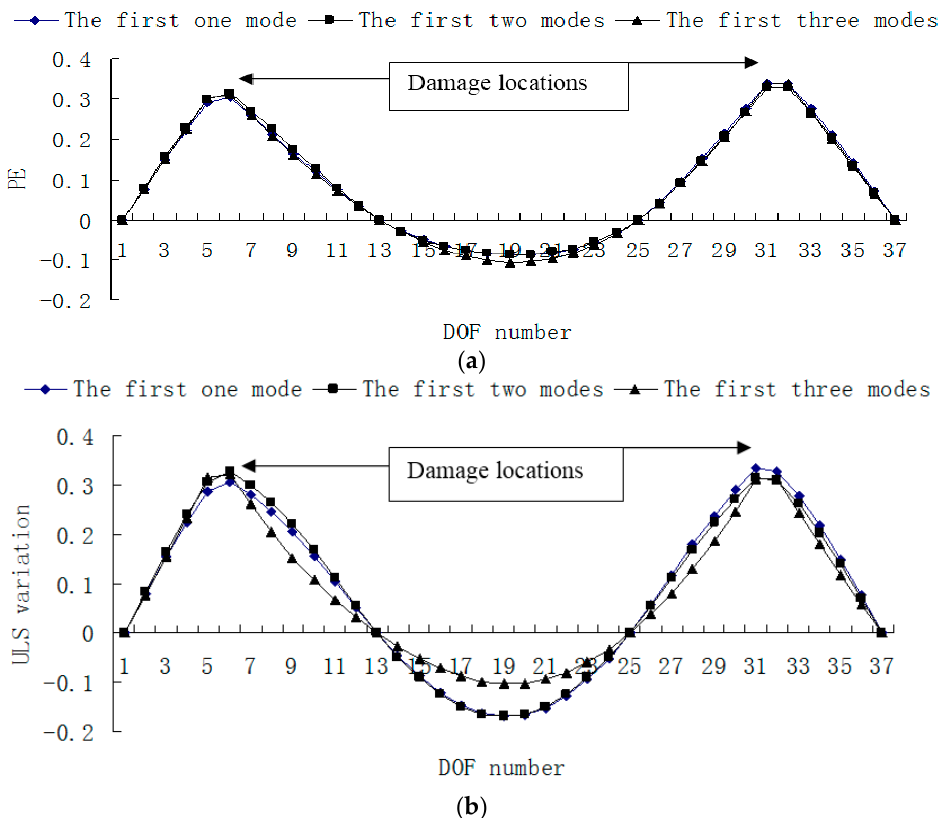
Figure 19. ( a ) Damage index (PE) map using the first one, two and three modes without noise, respectively, when elements 5 and 31 are damaged; ( b ) Damage index (ULS variation) map using the first one, two and three modes without noise, respectively, when elements 5 and 31 are damaged (×10 − 4 ).